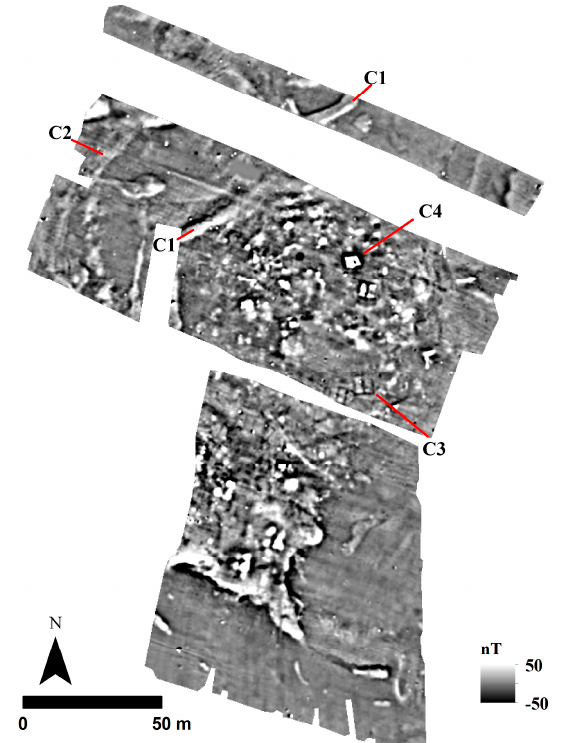
Figure 10. Geomagnetic prospection results from Karatsantagli.